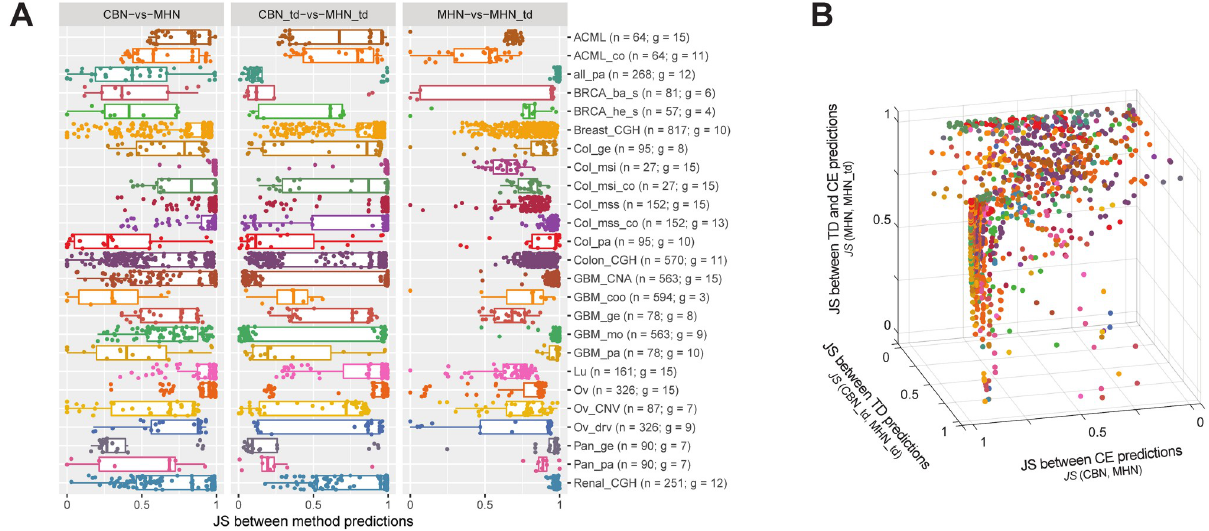
Fig 3. Similarity between predictions of three pairs of methods for the 25 biological data sets. For each data set, the JS divergence between the predictions of a pair of methods is represented in A: each of the three panels or B: each of the three axes. Dots correspond to all genotypes for which we computed predictions, which are the genotypes observed in the samples, except for the genotype with all genes mutated if it was observed. In parentheses, after the data set, we indicate the total sample size (n) and number of genes (g).